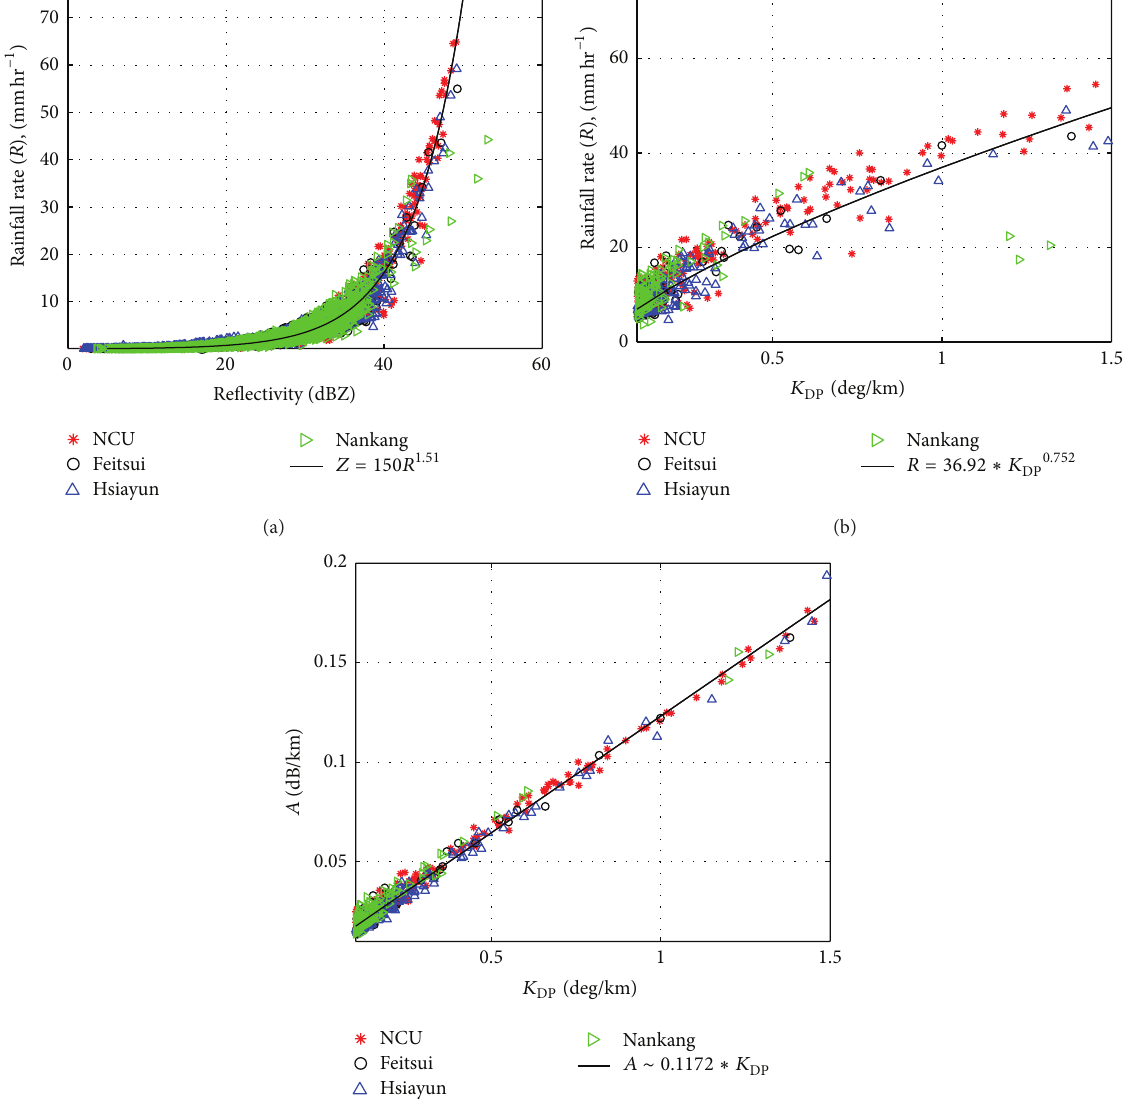
versus 𝑅 , and (c) 𝐾 versus 𝐴 . The scatters were obtained from different JWD observations: DP DP